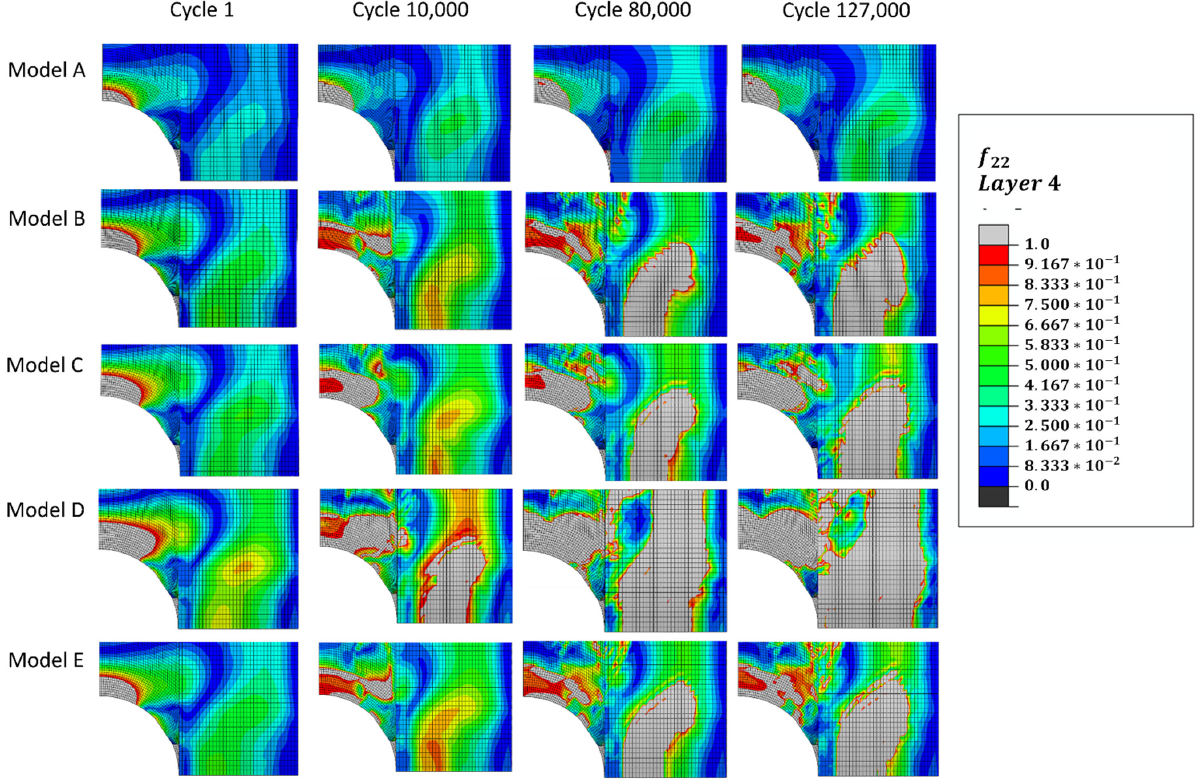
Figure 25. Exposure factor for matrix dominated fatigue failure (22 component of the surface ply). The scale is from 0 to 1.